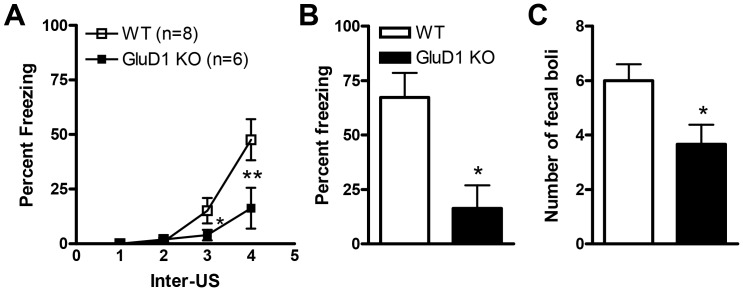
GluD1 KO mice manifest deficits in contextual fear learning.Significant deficit in fear acquisition is observed in GluD1 KO mice (n = 6) during the fourth US session compared to WT mice (n = 8) (P = 0.0400). 24 hrs later after fear conditioning, in the context post-test, the freezing response was significantly lower in GluD1 KO mice versus WT mice (P = 0.0113). Fecal boli produced were significantly lesser for the GluD1 KO mice versus WT mice (P = 0.0108). Data are presented as mean ± SEM. * represents P< 0.05.